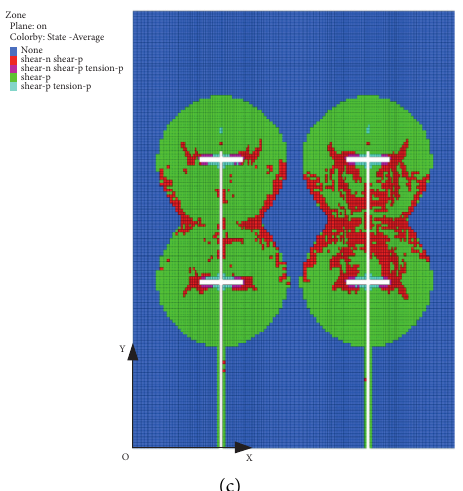
Figure 18: Distribution of the plastic zone around the slot with different spacings in Section 2. (a) 3.0m. (b) 4.0m. (c) 5.0